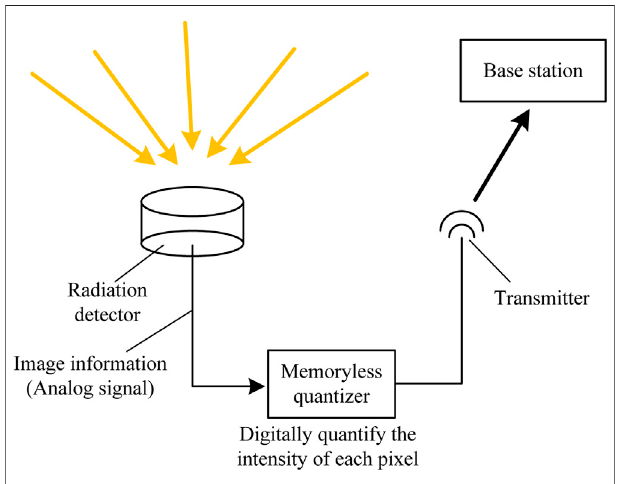
FIGURE 1 | Schematic diagram of the digital radiation detector